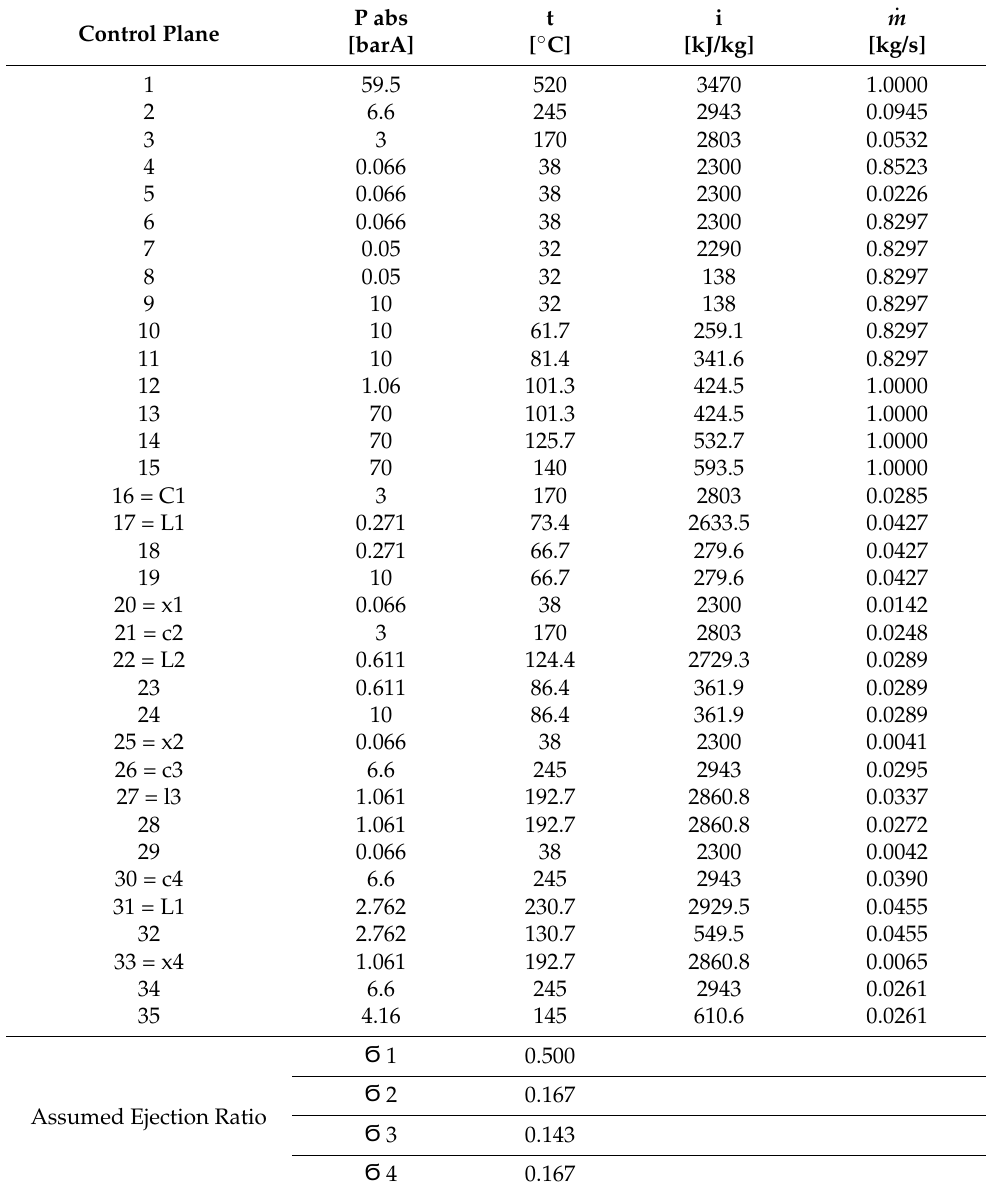
Table 6. Thermodynamic parameters of the working fluid in the control planes of a complex regenerative